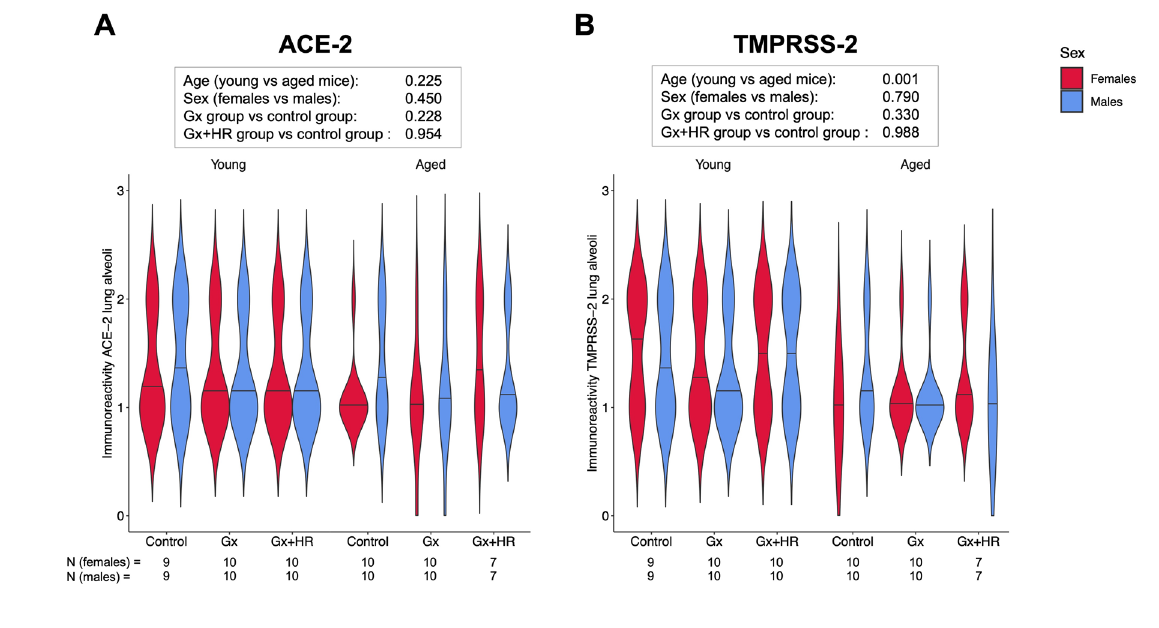
Figure 2. ACE-2 and TMPRSS-2 immunoreactivity in lung alveoli in murine models of ageing and hormonal manipulation. The violin plots provide information on the full data distribution. The horizontal black line indicates the median of the kernel density plot. ( A ) ACE-2 immunoreactivity in young (left panel) and aged (right panel) control animals, gonadectomized animals, and gonadectomized animals receiving long-term hormone replacement. ( B ) TMPRSS-2 immunoreactivity in young (left panel) and aged (right panel) control animals, gonadectomized animals, and gonadectomized animals receiving long-term hormone replacement. Ordinal logistic regression was performed to test the association between the level of expression of ACE-2 and TMPRSS-2 with age, sex, and hormonal status. The resulting p-values are reported in the box. ACE-2, angiotensin-converting enzyme 2; Gx, gonadectomy; HR, hormone replacement; TMPRSS-2, transmembrane protease serine